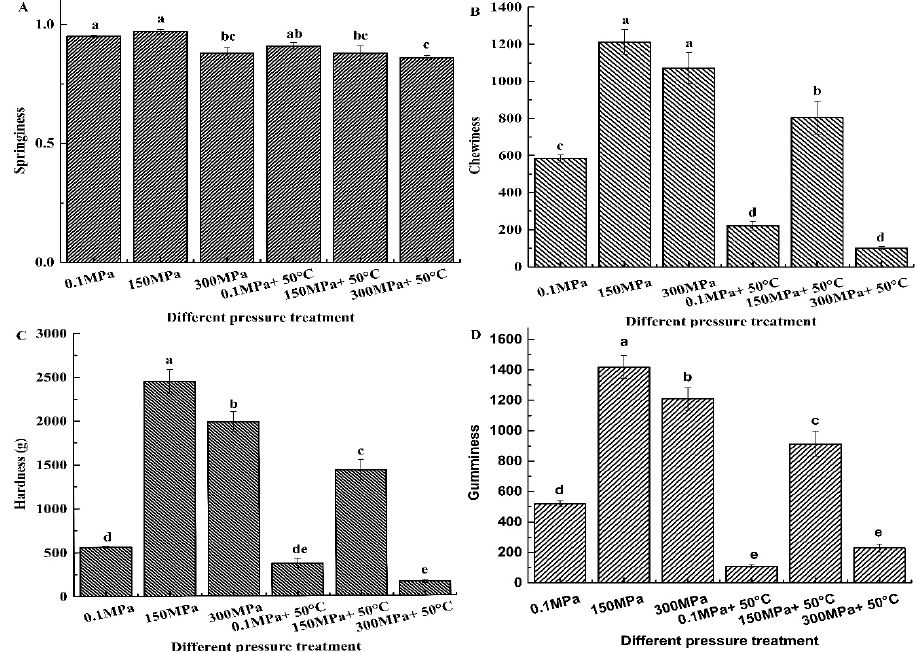
Figure 1. The effect of different treatment conditions (0.1 MPa, 150 MPa, 300 MPa, 0.1 MPa + 50 °C, 150 MPa + 50 °C, 300 MPa + 50 °C) on the texture (springiness, hardness (g), chewiness and gummi- ness). All values are means ± SE. abcde The different letters indicated the significant difference.